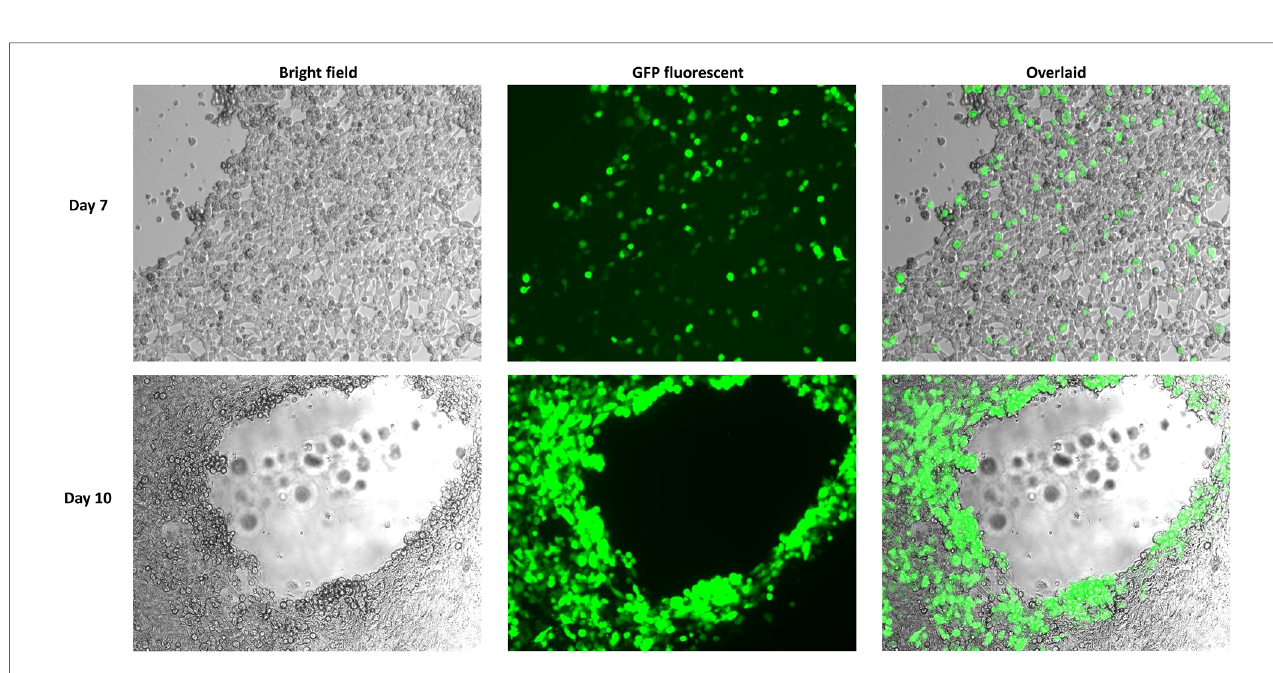
FIGURE 5 GFP fl uorescent imaging of AD293 cells 7 days and 10 days post transfection with the linearized rAdV55 genome. AD293 cells were seeded on a 6-well plate one day prior to transfection with linearized rAdV55. See the legend for Figure 4 for a description of the treatment and imaging of